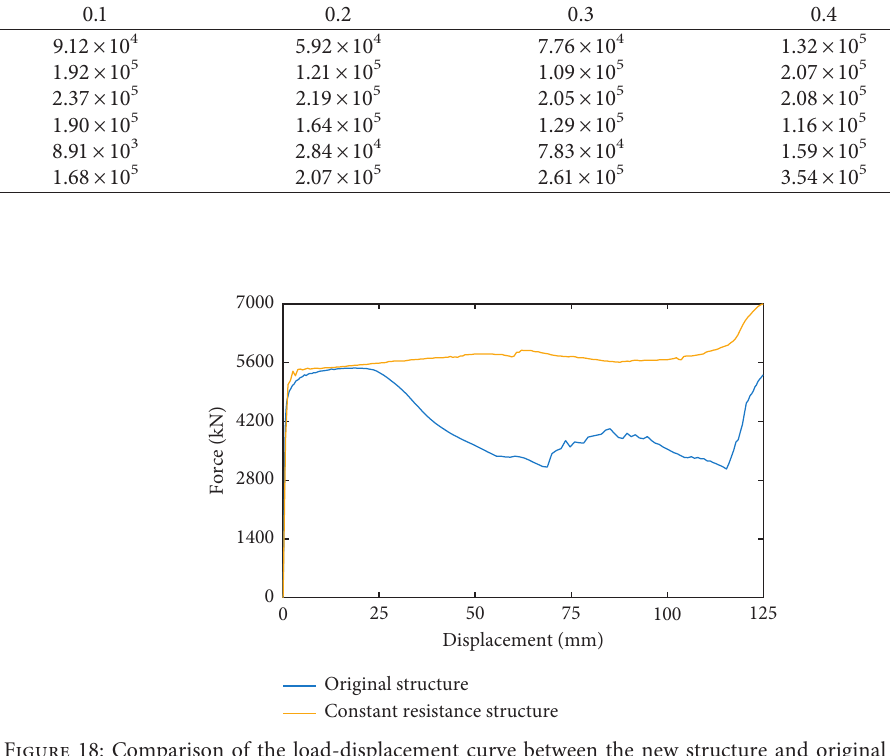
Table 3: Variance of the load-displacement curve of the device under a different friction coefficient and different thickening height. H